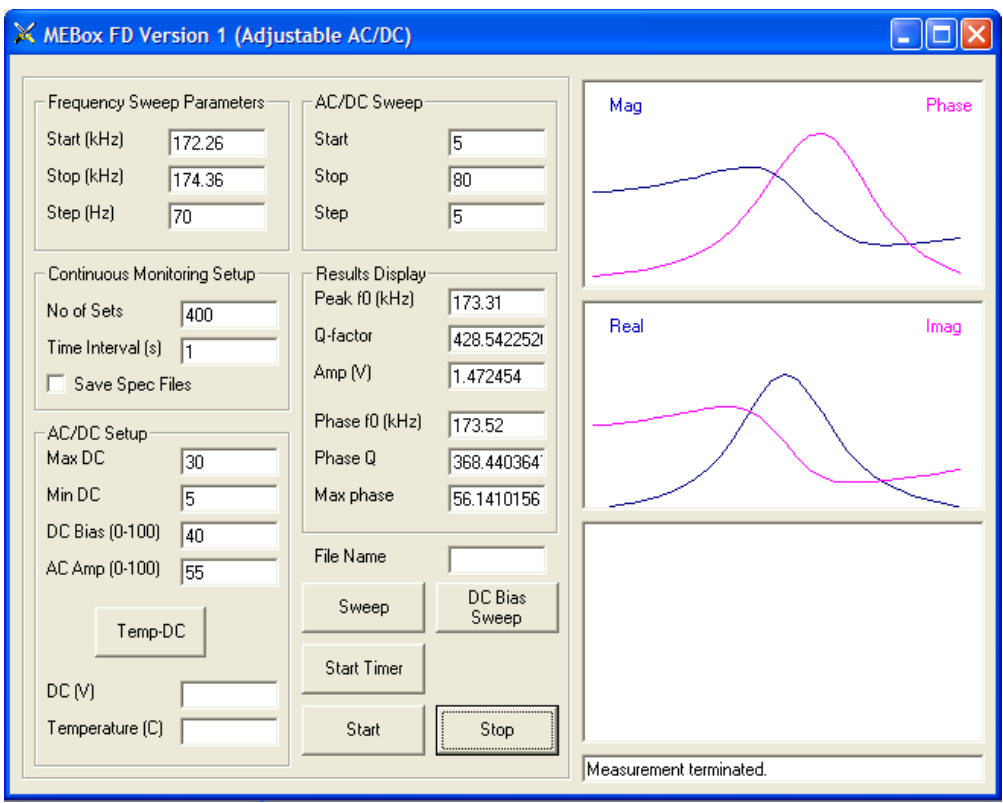
Figure 12. Snapshot of the graphic users’ interface (GUI) window used for single-channel magnetoelastic sensor measurements. Reprinted with permission from [41].